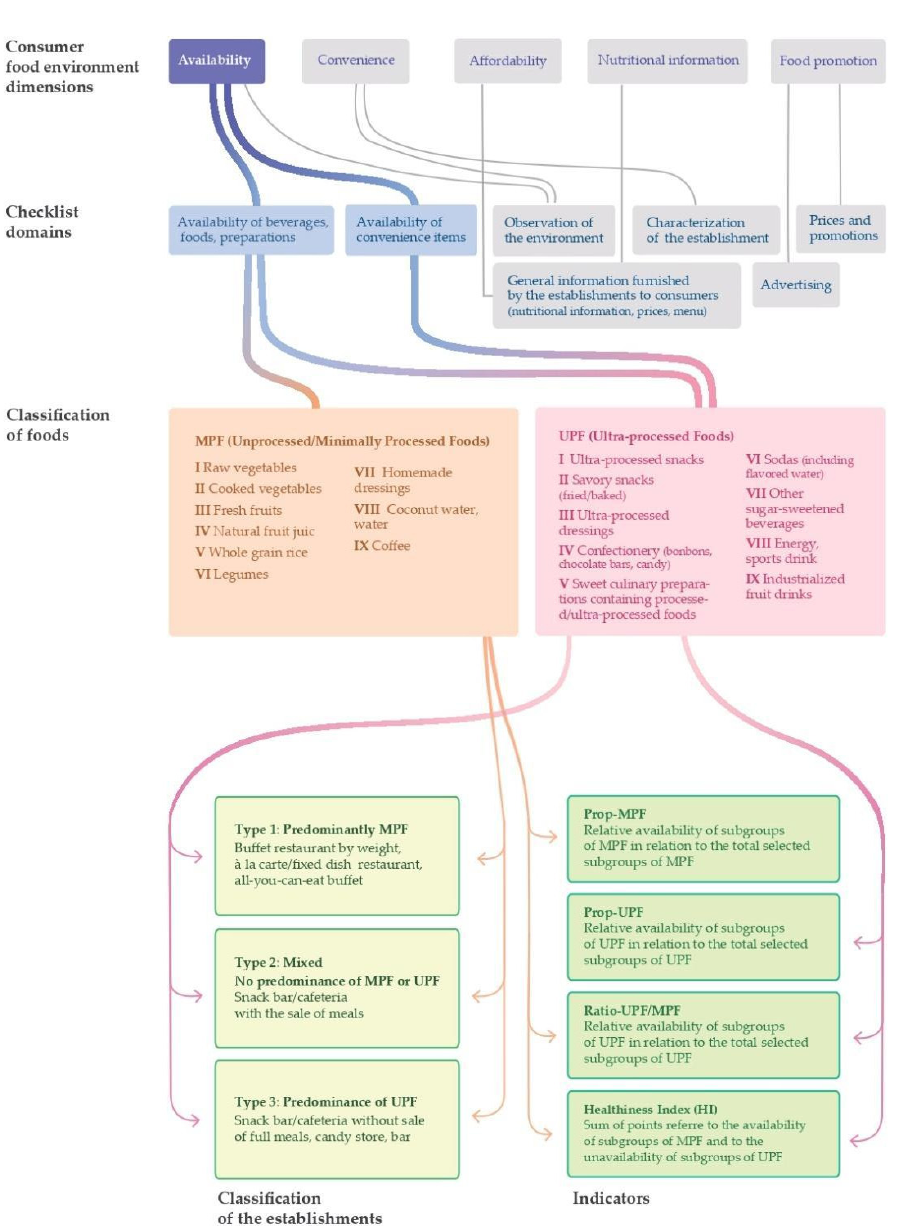
Figure 1. Flowchart for the development of healthiness indicators for commercial establishments that sell foods for immediate consumption.